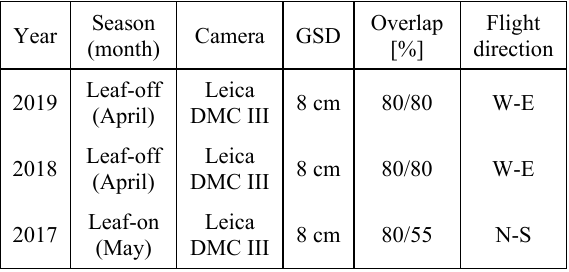
Table 1. Flights parameters of images acquisition.